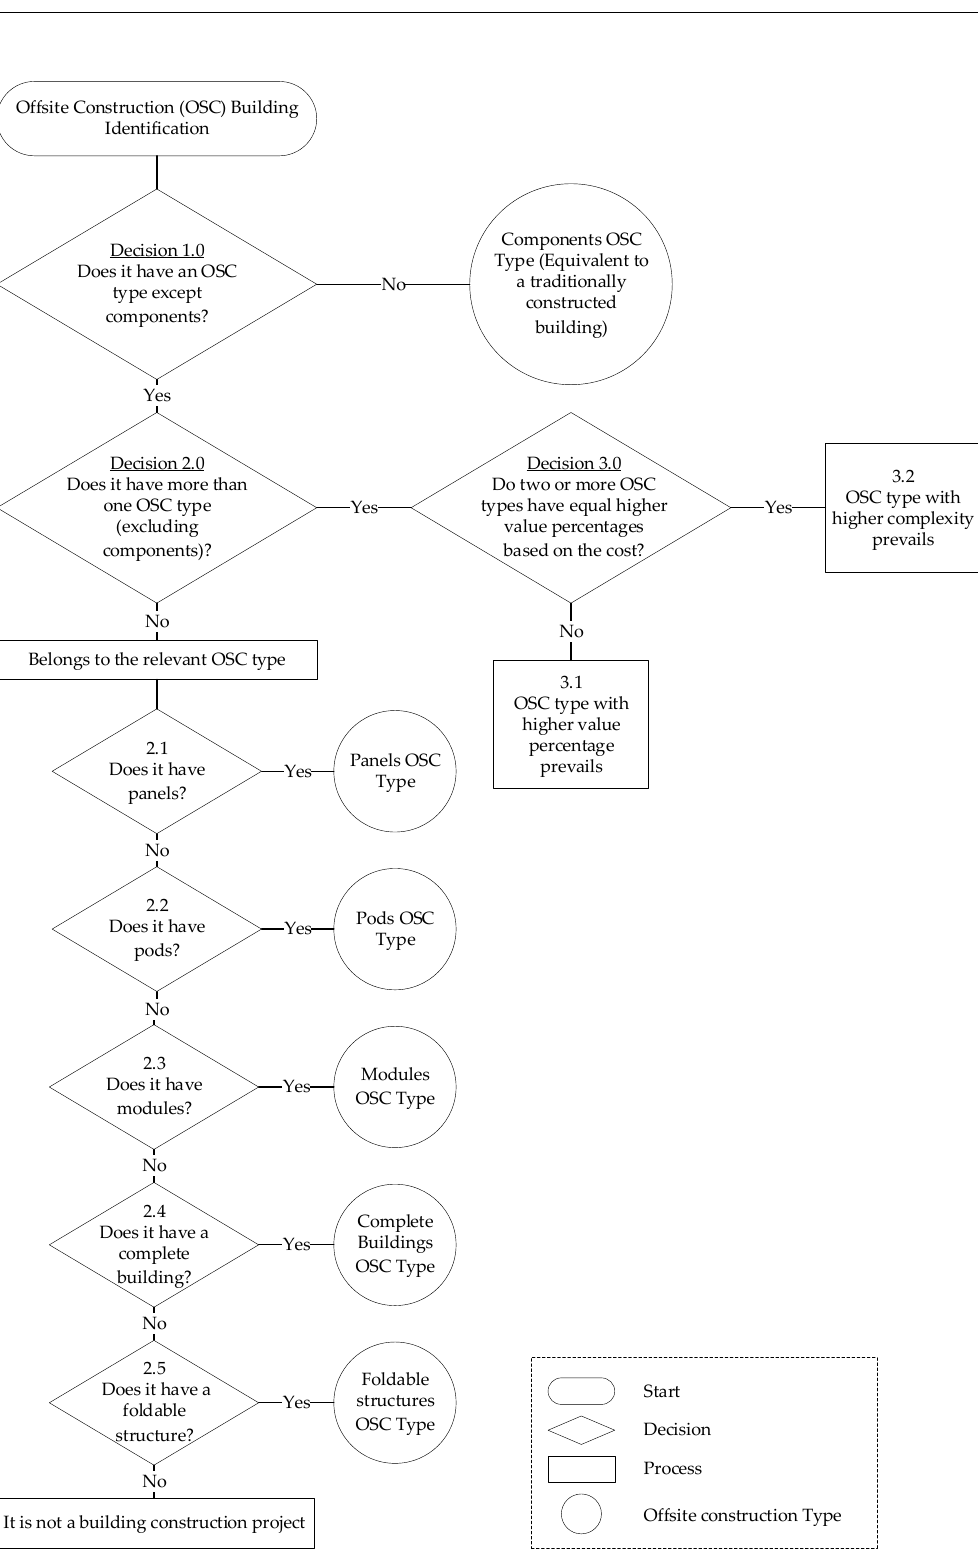
Figure 4. OSC building classification process.